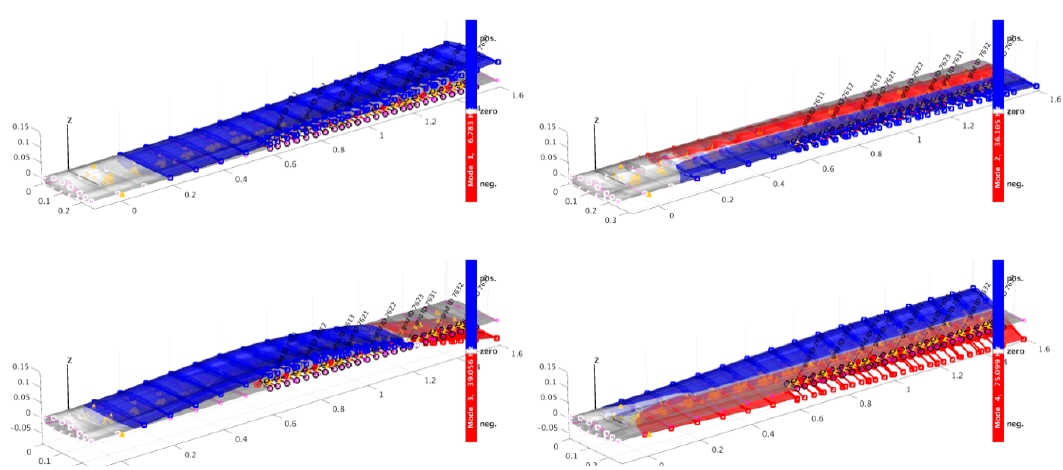
Figure 20. Mode shapes of the updated finite element model